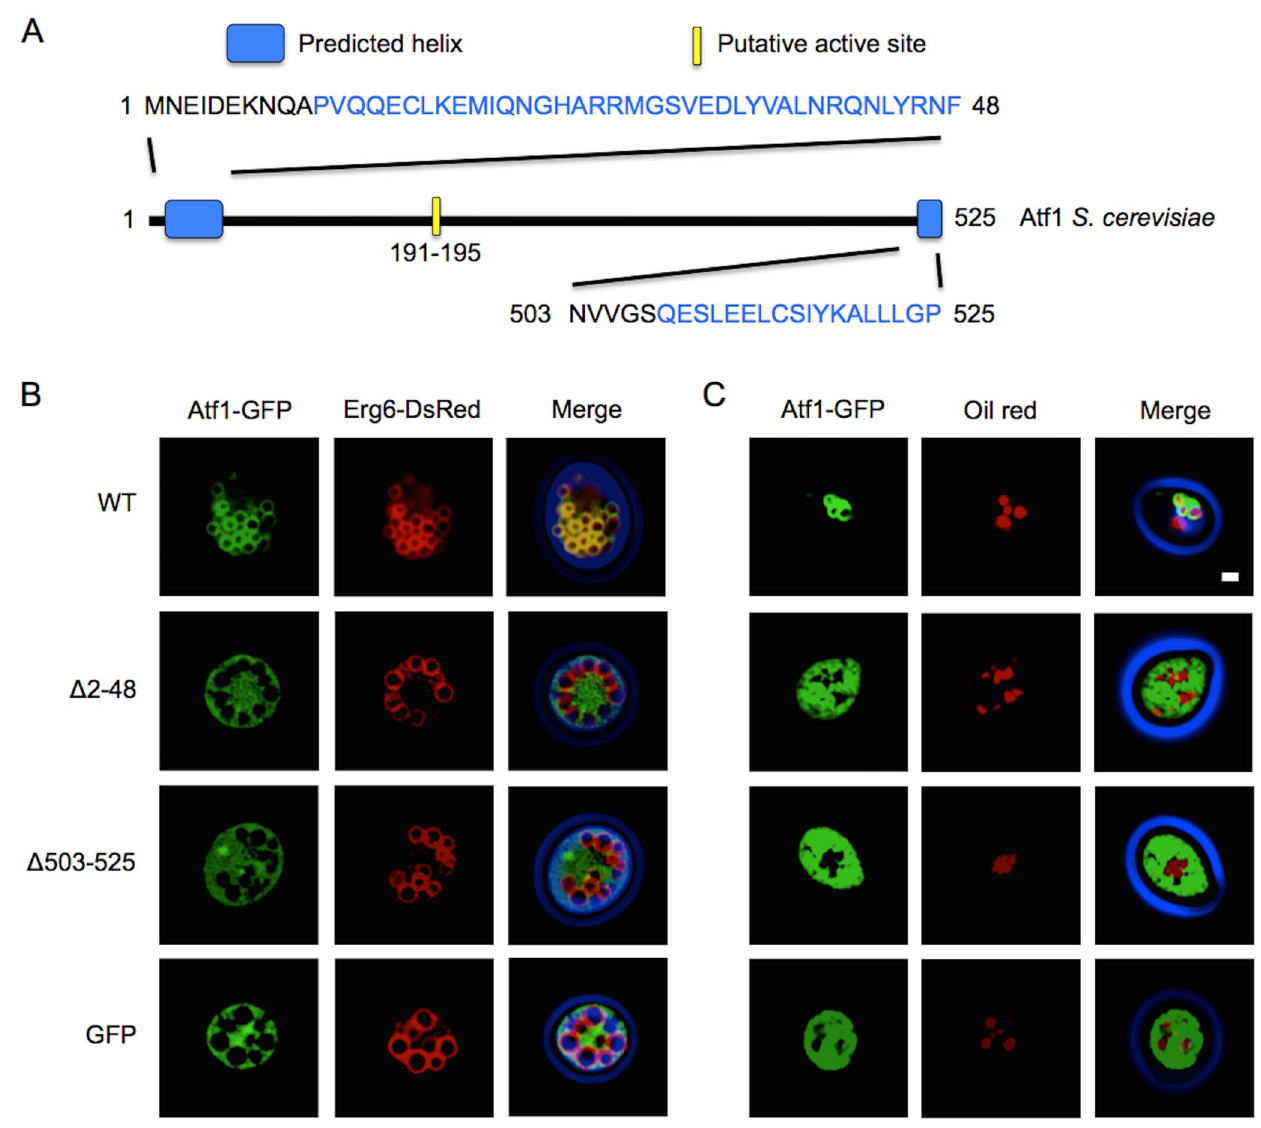
Figure 1. The N- and C-terminal domains of Atf1 are necessary for lipid droplet localization. (A) Atf1 from S. cerevisiae with the location of the putative active site and predicted N- and C-terminal helices. The amino acid sequence of the terminal helices are shown. (B) Fluorescent microscopy images of selected stationary phase cells cultured in oleic acid media co-expressing Atf1-GFP and the LD marker Erg6-DsRed (Ex. 400 6 50, Em. 500 6 25). Atf1-GFP signal is shown in green and Erg6-DsRed is shown in red. The merged image shows the phase contrast image false colored in blue. Co-localization of green and red is indicated by yellow and demonstrates Atf1-GFP localization to LDs in the wild type (WT) Atf1. A GFP control shows cytosolic localization. (C) Fluorescent images of stationary phase cells cultured in glucose media overexpressing Atf1-GFP with LD oil red staining (red). Localization of WT Atf1-GFP around stained LDs indicates LD localization. Quantification of fluorescence microscopy was performed by counting a minimum of 300 cells from three independent experiments. LD localization was observed in 91 6 1% of cells expressing wild type Atf1 and 0% for D 2–48, D 503–525, and the GFP control. In both oleic acid and glucose media WT Atf1-GFP associates with LDs. N- or C-terminal truncations ( D 2–48 and D 503–525, respectively) result in cytosolic GFP signal indicating a loss of LD localization. Scale bar, 1 m